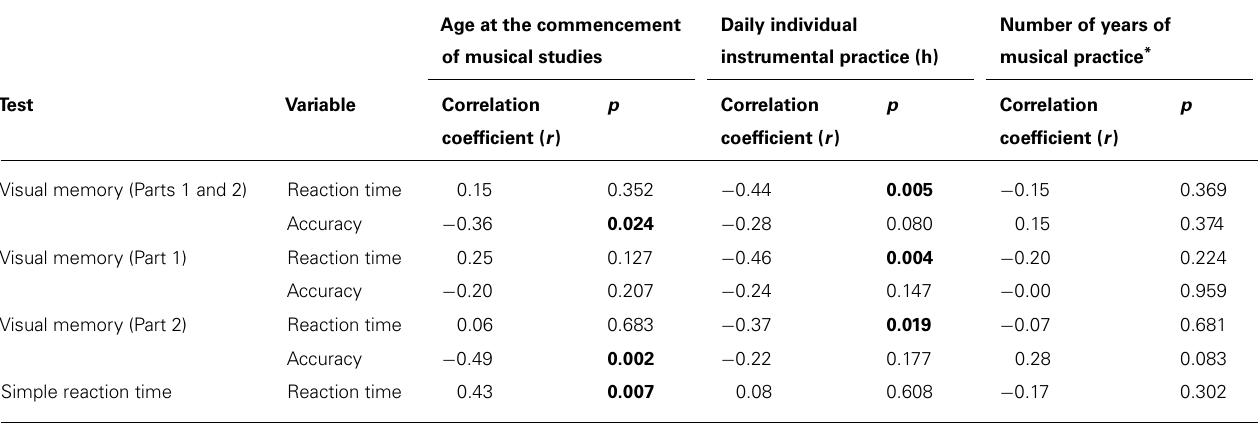
Table 2 | Correlations between performance of musicians in the visual memory test and in the simple reaction time test and variables related to musical practice.